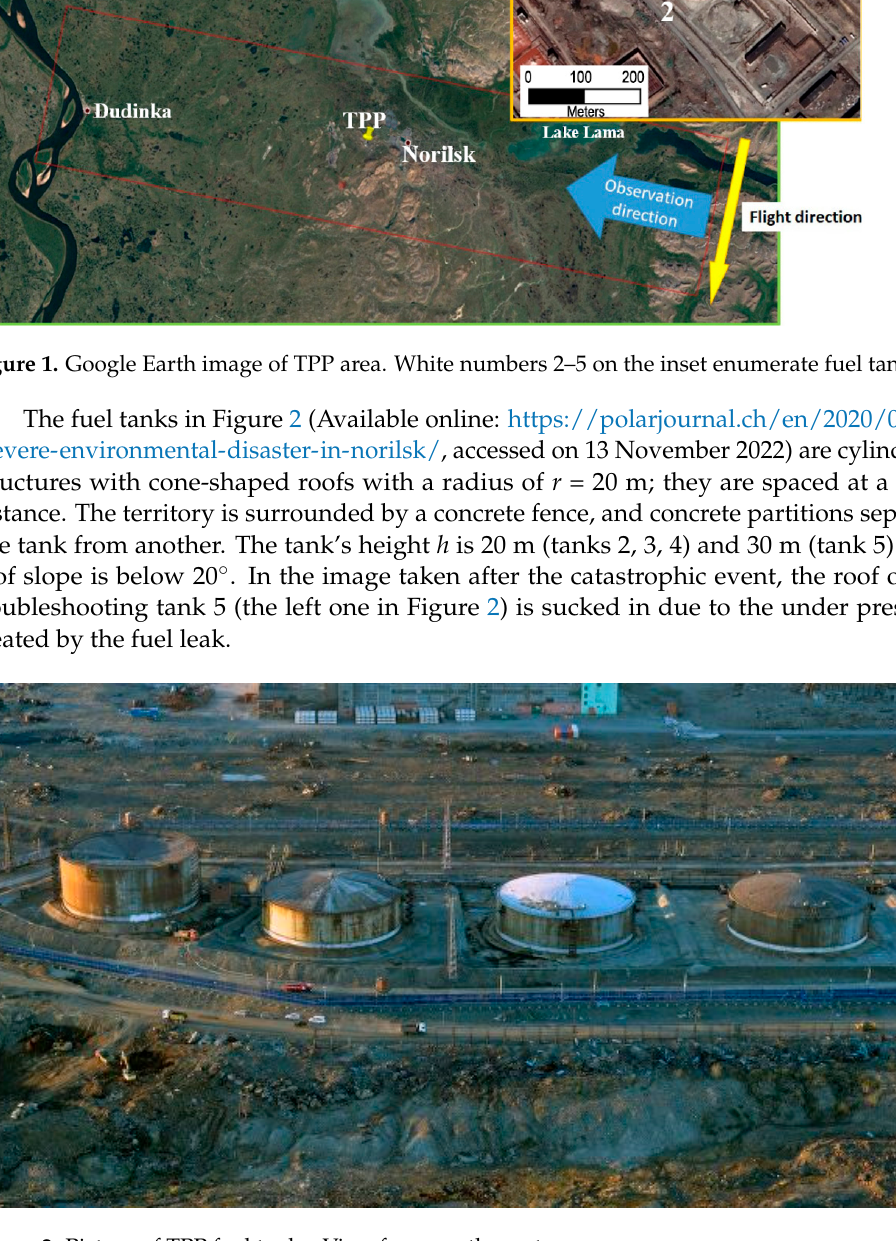
Figure 2. Picture of TPP fuel tanks. View from south-west.